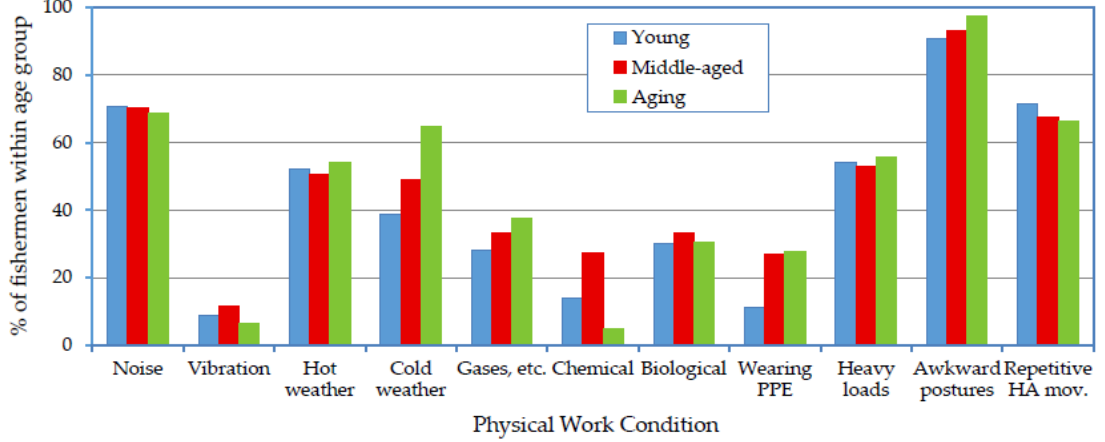
Figure 5. Exposure of fishermen to physical work conditions according to age group.